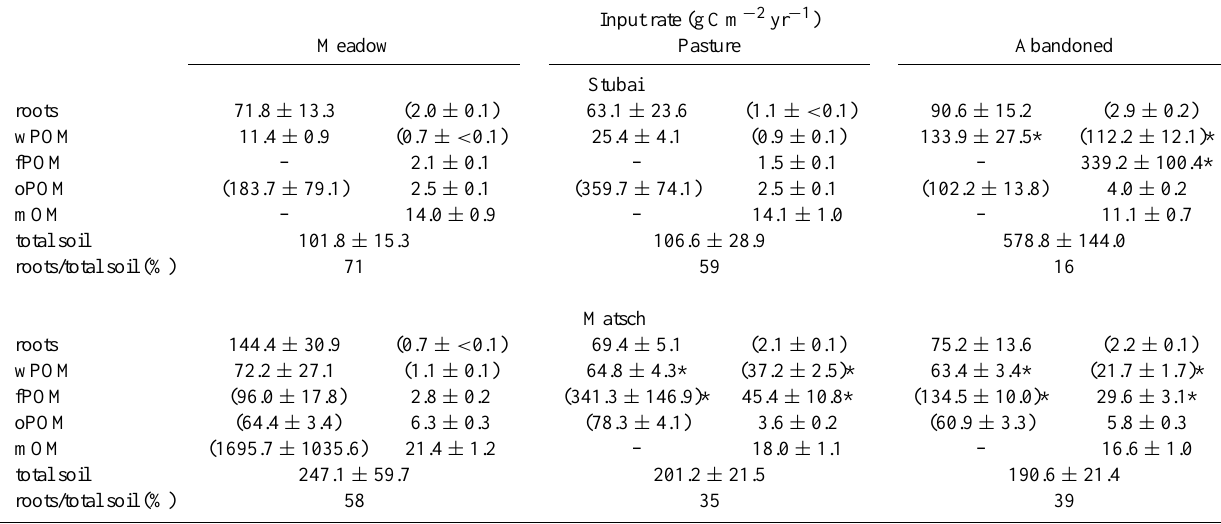
Table 3. Input rates I for roots, SOM fractions, total soil (roots+SOM) and contribution of roots to soil C input of meadow, pasture and abandoned grassland at the Stubai and Matsch site. I was calculated based on the radiocarbon signature using steady-state and nonsteady- state models (*). Both models produce two solutions yielding in the measured radiocarbon content and C stock in 2008. Implausible solutions are put in parenthesis. For the definition of implausible solutions see methods.